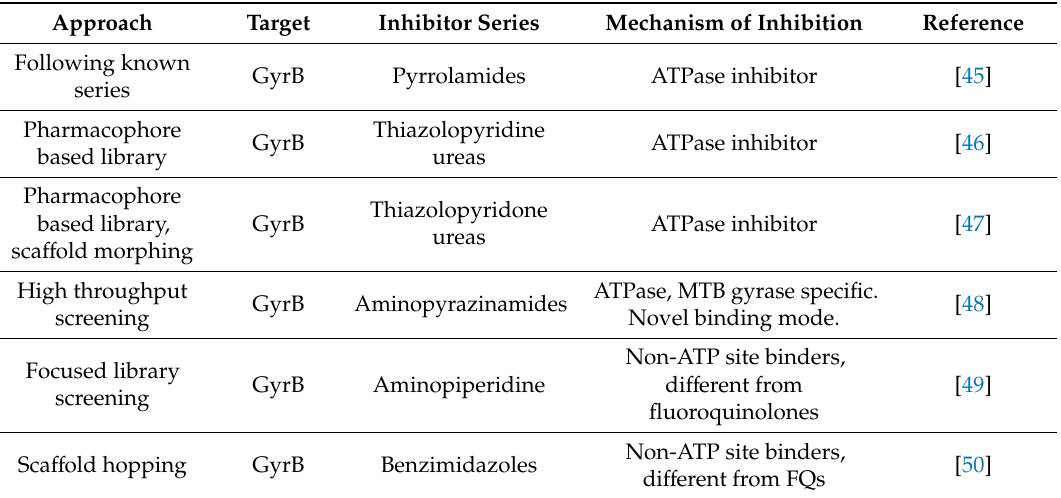
Table 1. Gyrase inhibitors identified at AstraZeneca